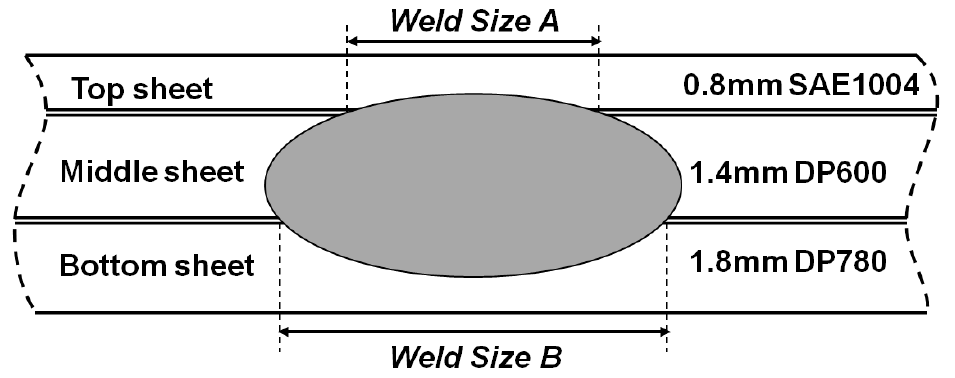
Figure 3. Weld nugget configuration in weld-bonding of three steel sheets.